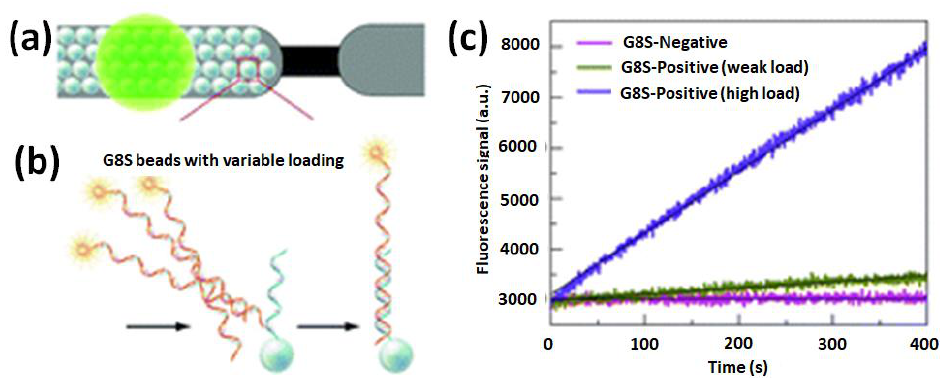
Figure 14. ( a ) Schematic microfluidic microarray hybridization on tightly packed monolayer bead bed inside a microfluidic cartridge for the detection of single-nucleotide polymorphisms; ( b ) real-time monitoring of DNA hybridization on spherical particles functionalized with oligonucleotide capture probes nominated as G8S. ( c ) Fluorescence emission detection from real-time monitoring of DNA hybridization events vs. the pass of time. Reprinted with permission ref. [118]. Copyright 2021, RSC.